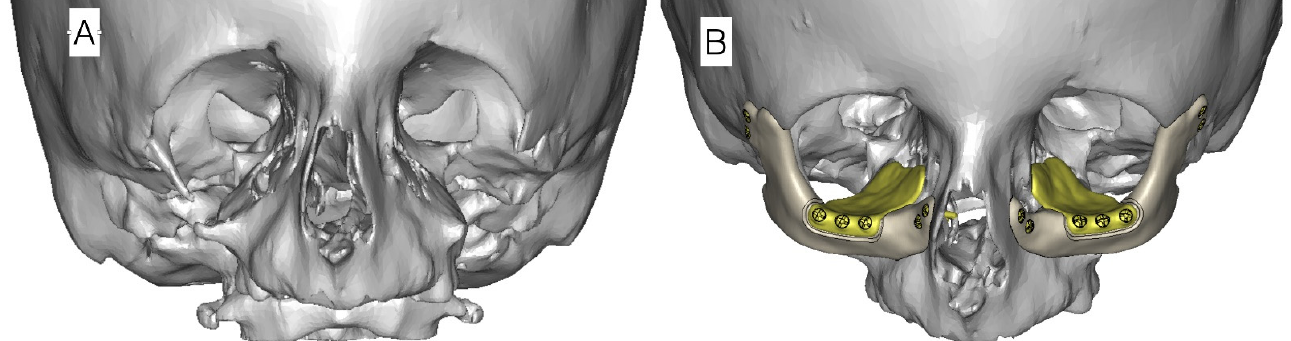
Figure 8. Example of virtual planning of zygomatic bone reconstruction with alloplastic implants. ( A ) Computed tomography image prior to transplantation in a patient with missing zygomatic bone. ( B ) CT scan image with planned alloplastic zygomatic bone reconstruction and individual orbital floor recontouring plates.